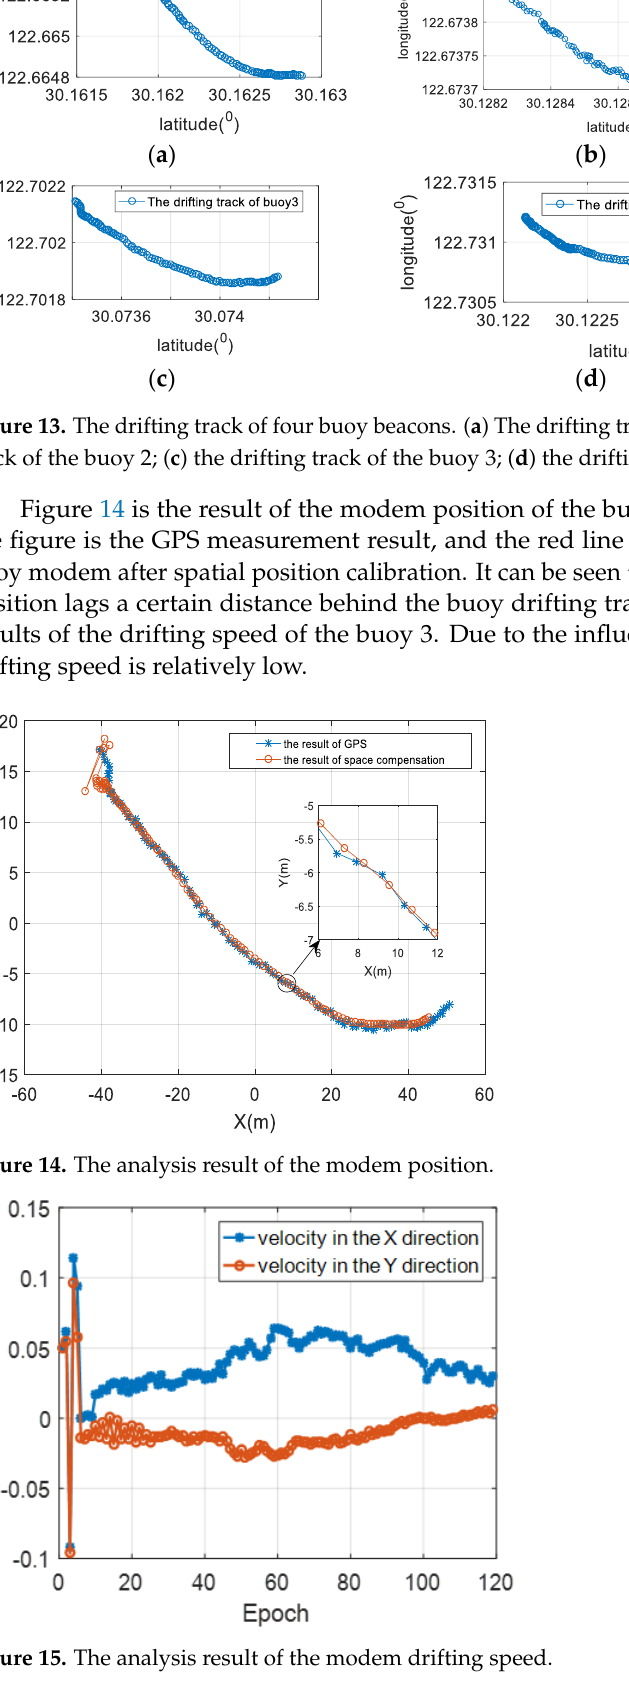
Figure 15. The analysis result of the modem drifting speed. The result of the positioning signal after delay calibration is shown in Figure 16. The dotted line in the figure corresponds to the measurement delay of the 70th positioning cycle. The enlarged view in the lower right corner corresponds to the measurement delay after compensation. ( b ) Figure 16. The relative delay result of the positioning signal after delay calibration ( a ) The relative delay of four positioning signal after delay calibration; ( b ) the relative delay of the 70th positioning cycle.